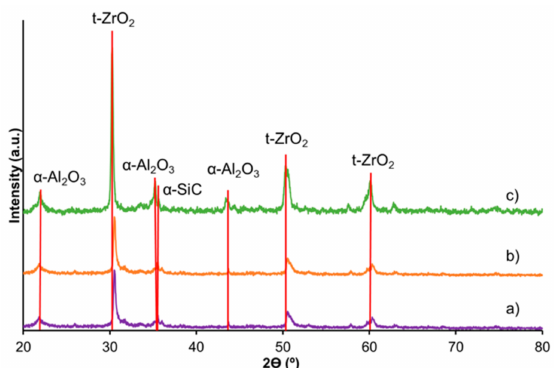
Figure 5. XRD pattern of Al 2 O 3 /TZ-3YS coatings: ( a ) without reinforcement; ( b ) SiC-reinforced; ( c ) with fructose and